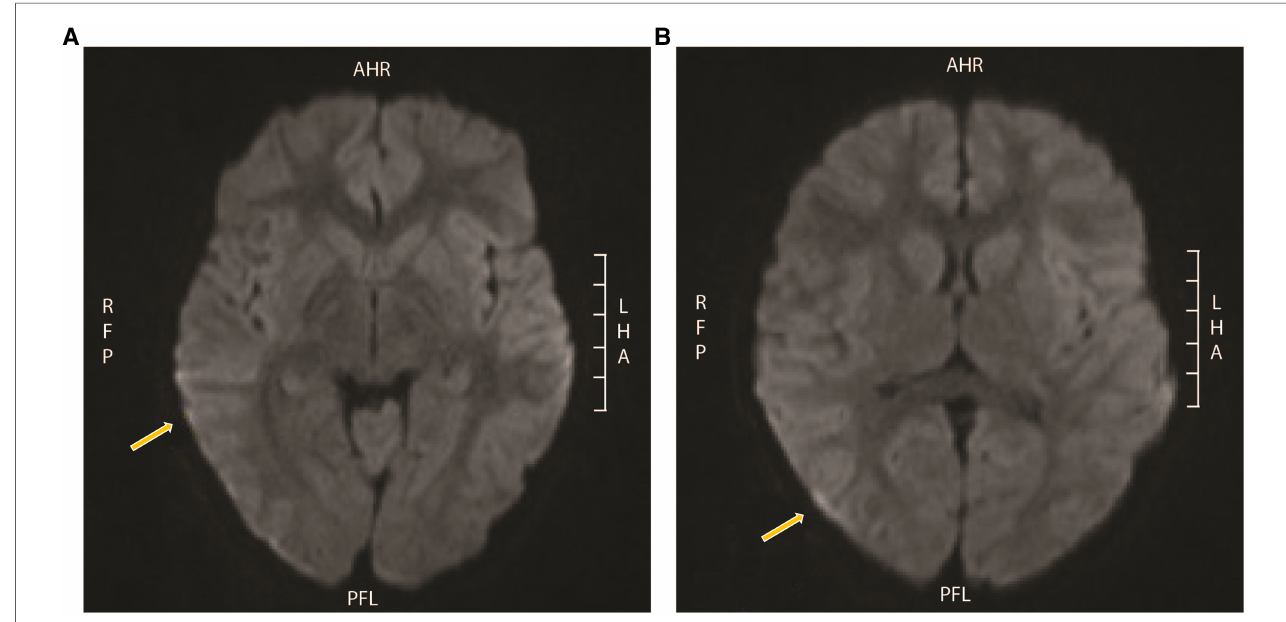
FIGURE 2 MRI from patient 1. Hypersignal on FLAIR within the sulci of the bilateral cerebral hemispheres, especially in the ( A ) posterior parietal and ( B ) occipital regions with minimal restricted diffusion in the extra-axial spaces of the bilateral temporal and occipital regions, and also increased linear enhancement in the sulci that is likely vascular and suggests the presence of hyperemia. MRI, magnetic resonance imaging; FLAIR, fl uid-attenuated inversion